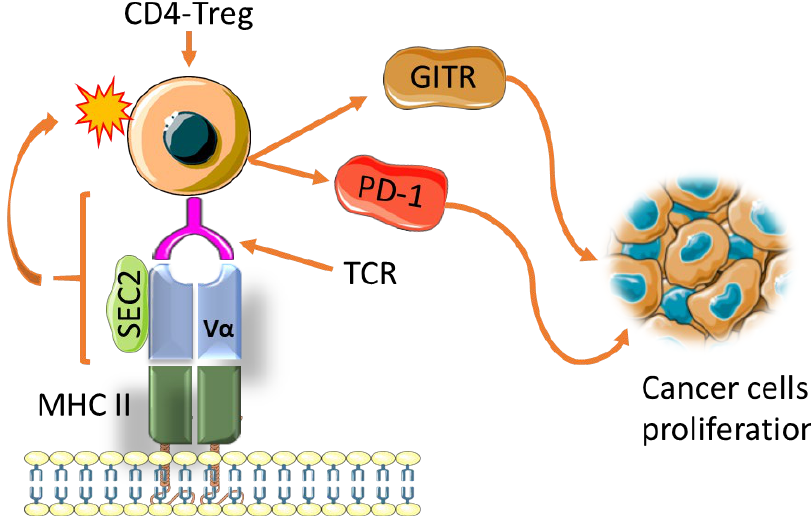
Figure 6. Enhanced immunosuppressive effect of SEC2-induced by activation of related cytokines serves as a barrier for effectively using these SEs as a treatment for cancer. Immunosuppressive Tregs are the major source of immune checkpoints such as GITR and also express PD-1. Tregs use these cytokines as one of the multiple ways to block anticancer mechanisms and aid in cancer cell proliferation and survival.